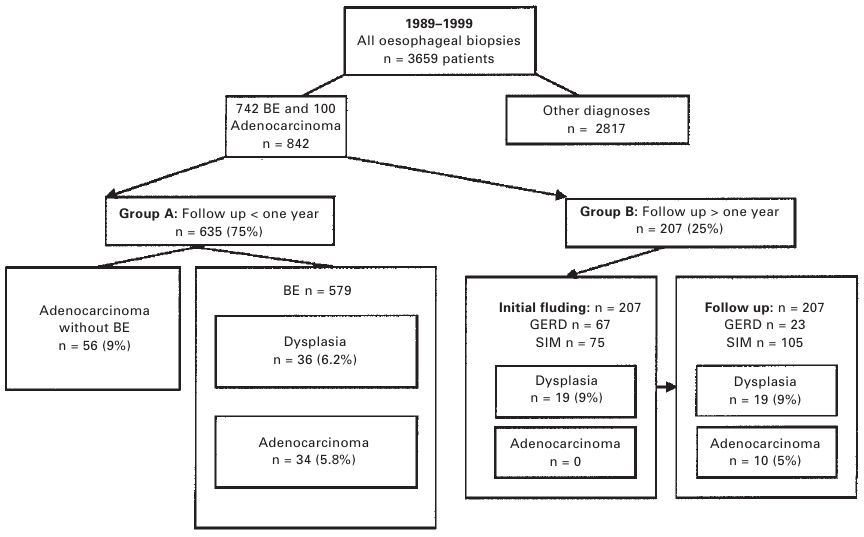
Study population, divided according to length of follow-up, group A <1 year and B >1 year. The pres- ence of dysplasia and adenocarcinoma in initial and subse- quent biopsy speci- mens is